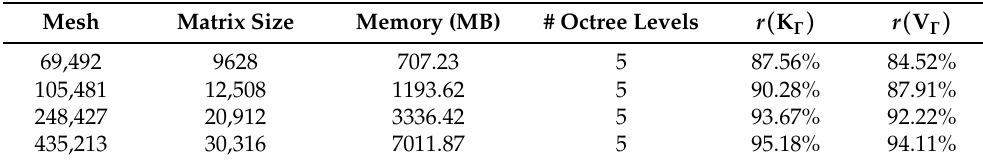
Table 9. Compression ratio of single-layer matrix K Γ and double-layer matrix V Γ with ACA.